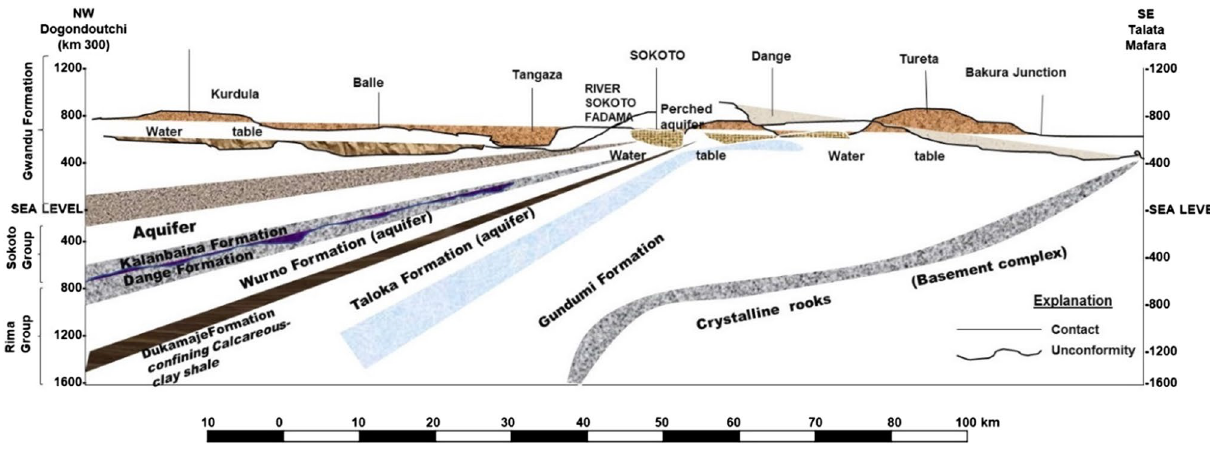
Fig. 3 The geological cross section of Sokoto